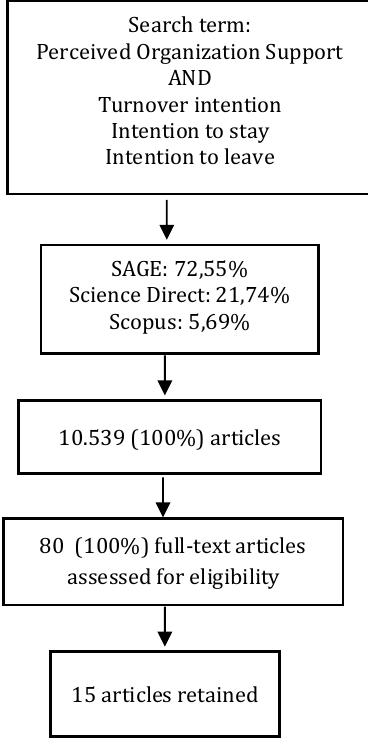
Figure 1: Literature search